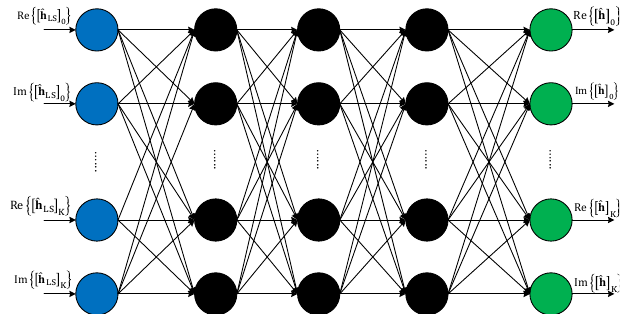
Figure 5. The illustration of the FDNN-based channel